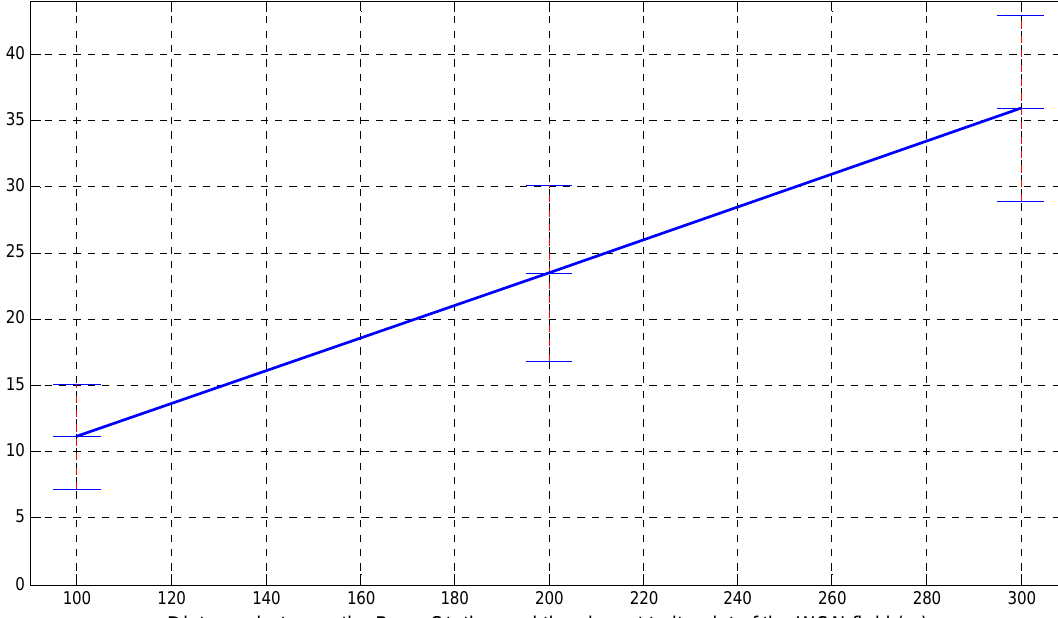
Distance between the Base Station and the closest to it point of the WSN field